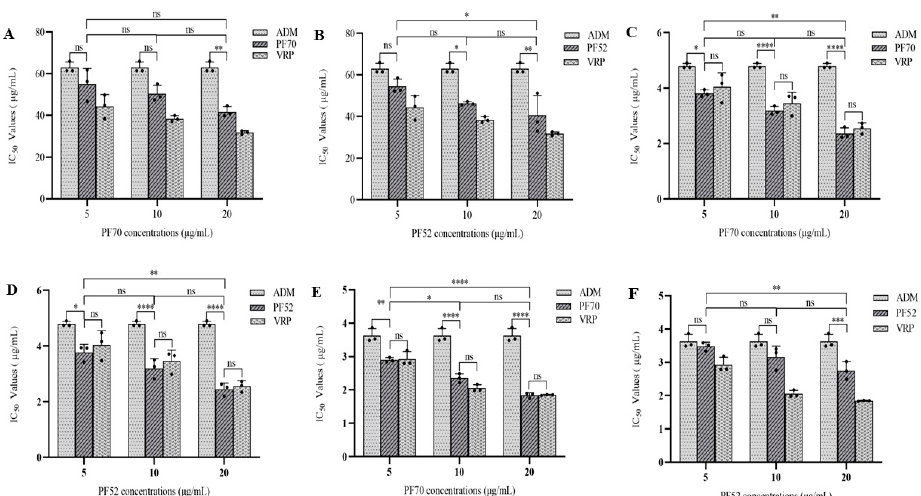
Figure 5. IC 50 values of ADM at different concentrations combined with compound 1 (PF70) and 2 (PF52) at concentrations of 0, 5, 10, 20 µ g/mL, respectively: ( A ) compound 1 (PF70) against MCF- 7/ADM; ( B ) compound 2 (PF52) against MCF-7/ADM; ( C ) compound 1 (PF70) against K562/ADM; ( D ) compound 2 (PF52) against K562/ADM; ( E ) compound 1 (PF70) against A549/ADM; ( F ) com- pound 2 (PF52) against A549/ADM. All experiments were performed in triplicate. ns p ﹥ 0.05, * p < 0.05, ** p < 0.01, and *** p < 0.001, and **** p < 0.0001. Table 2. The reversal effects of compounds toward MCF-7/ADM, K562/ADM and A549/ADM.